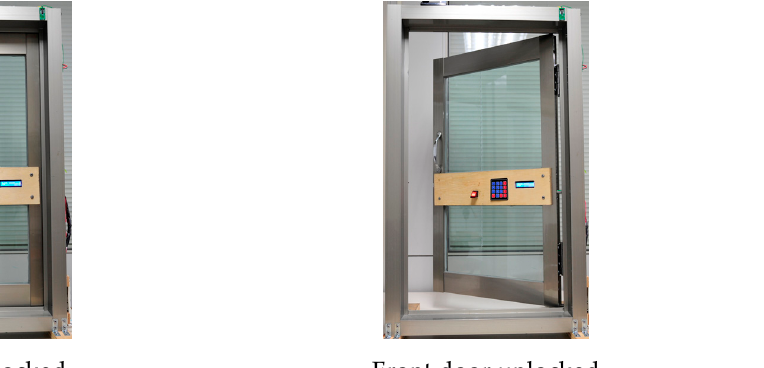
Appl. Sci. 2019 , 9 , x FOR PEER REVIEW Figure 17. Line notification messages on the mobile device. Figure 17. Line notification messages on the mobile device. Figure 17. Line notification messages on the mobile device. Figure 17. Line notification messages on the mobile device.